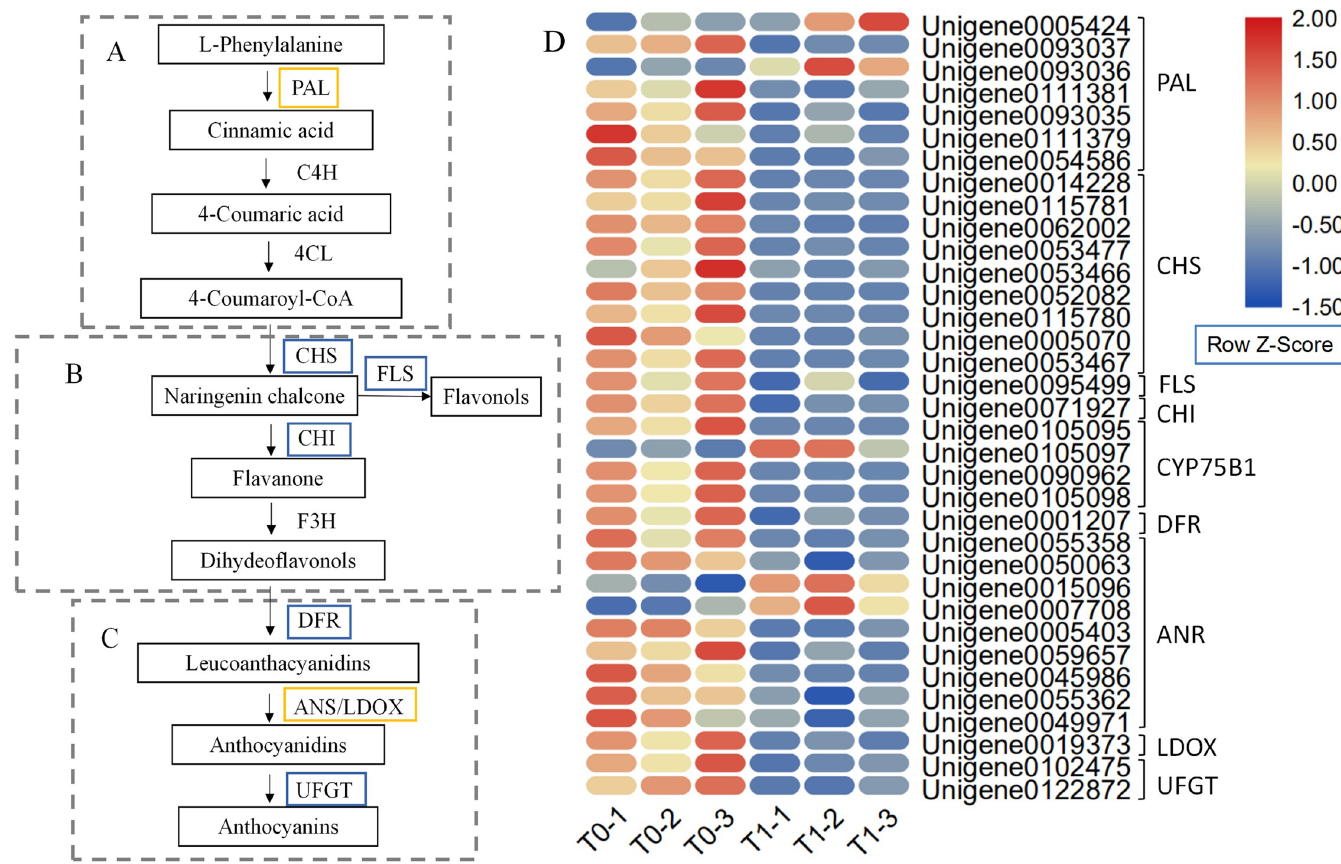
Fig 6. Anthocyanin biosynthesis pathway and heat map. The first (A), second (B), and third (C) stages of anthocyanin biosynthesis [31, 32]. The blue box indicates downregulated genes, and the orange box indicates both upregulated and downregulated genes.